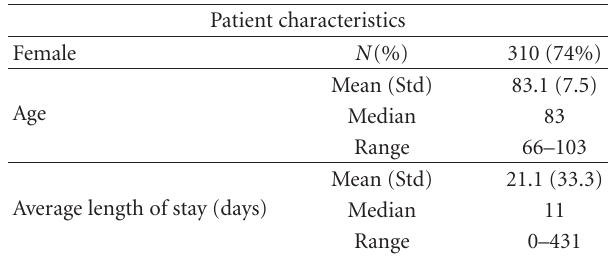
Table 1: Demographics ( n =